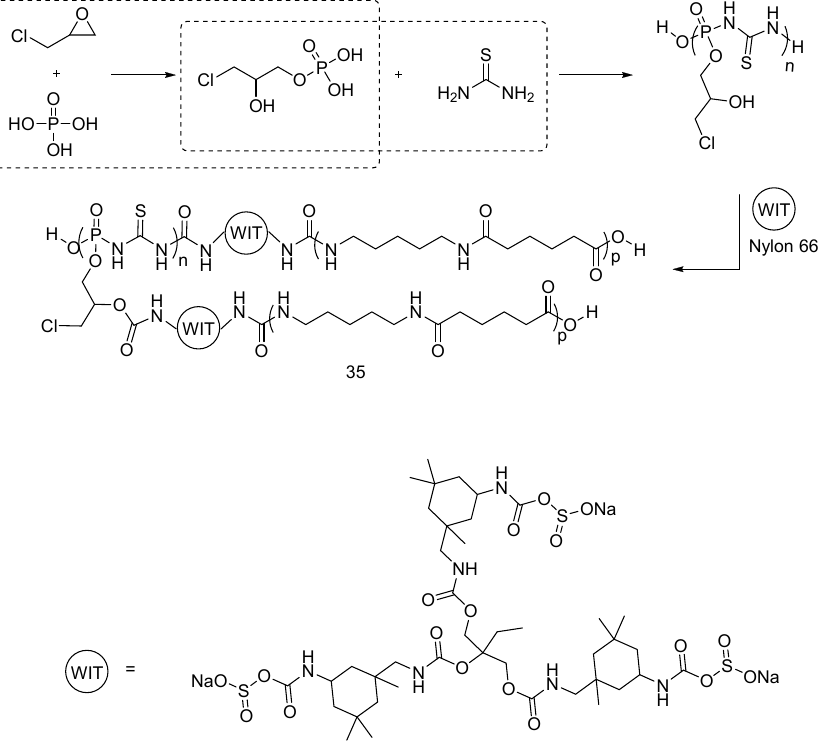
Figure 25. Synthetic route of polymeric additive ( 35 ).